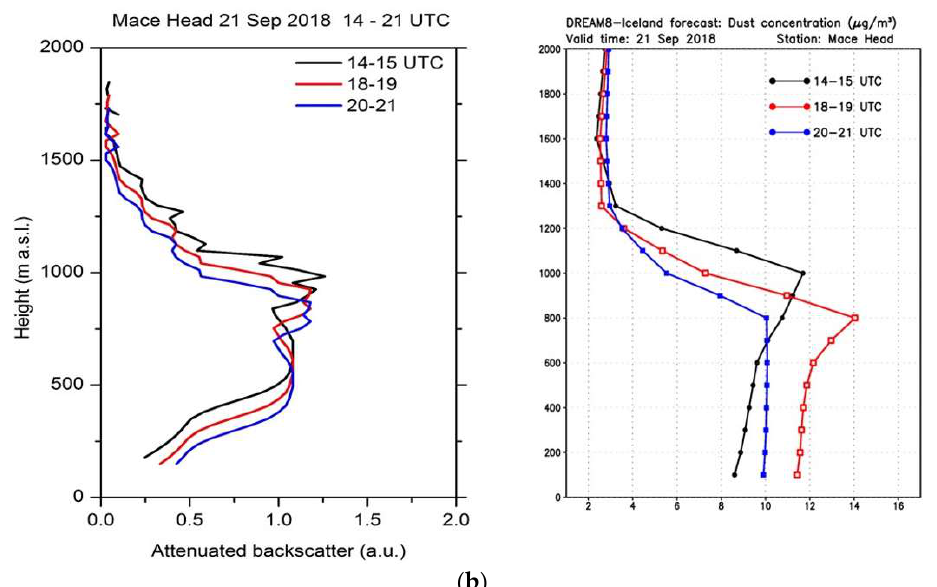
Figure 17. Mace Head station: ( a ) Time series of the model dust concentration (µgm −3 ) (upper) and ceilometer attenuated backscatter (lower), along with aerosol type classification inferred using air mass back trajectories; and ( b ) vertical profiles of the attenuated backscattering calculated from the ceilometer observations (left) and of the dust concentration (µgm −3 ) predicted by the model (right) for selected time intervals. Note: Boxes in the model images are approximately positioned in accordance to those specified in the LIDAR/ceilometer analysis plot.